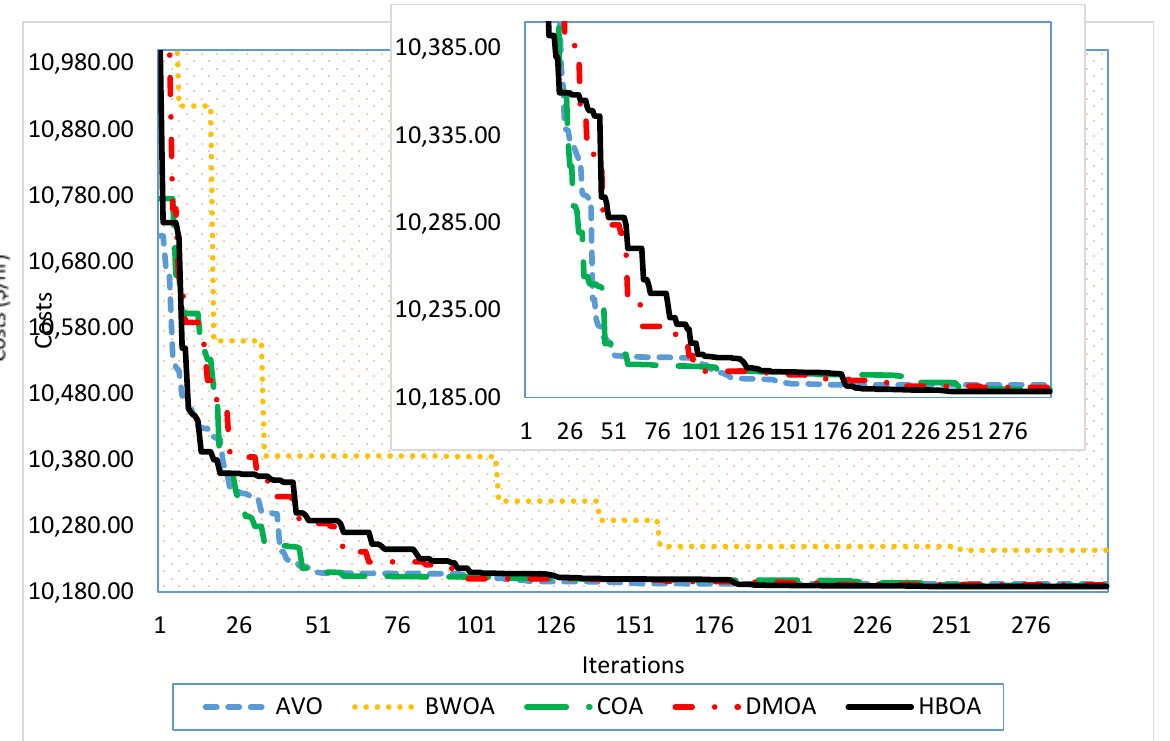
Figure 7. Convergence rates of the proposed HBOA and the AVO, DMOA, COA, and BWOA of Case 2 for the second loading.